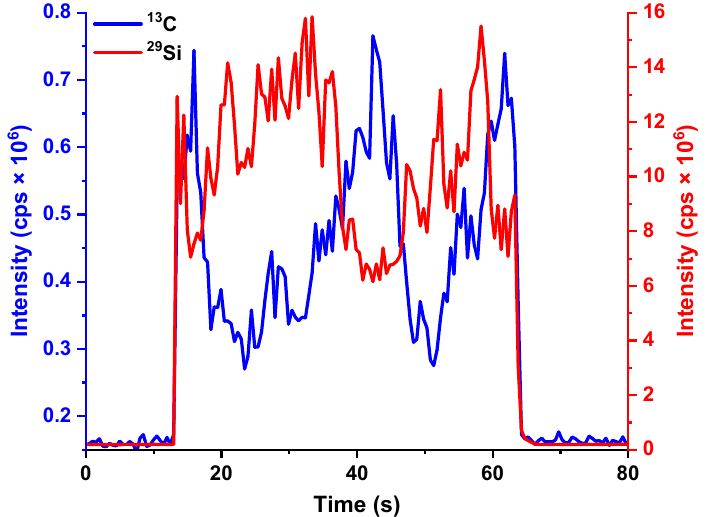
Figure 4. 13 C and 29 Si ablation signals recorded by analyzing SiC-3. Spot size = 120 µm, length = 1 mm, scanning speed = 20 µm/s, frequency = 10 Hz and fluence = 3.8 J/cm 2 .